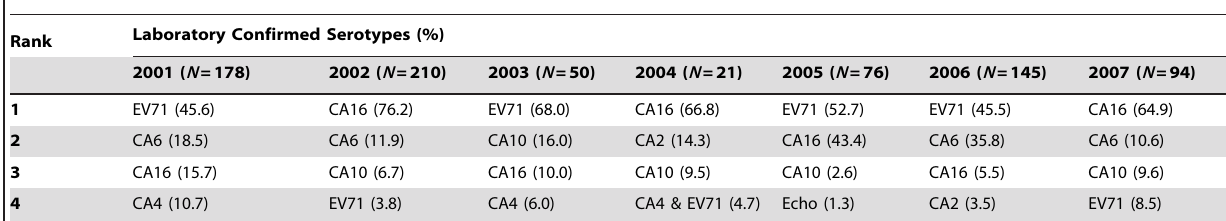
Table 3. Top serotypes of enterovirus isolated from HFMD patients in Singapore, 2001–2007.